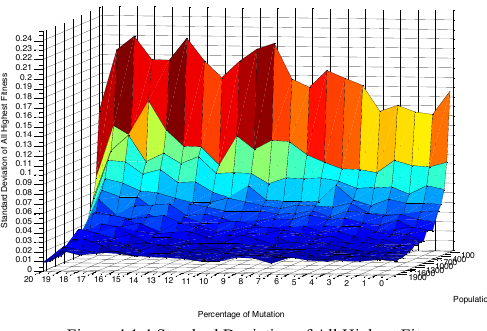
Figure 4.1.4 Standard Deviation of All Highest Fitness Figure 4.1 Total Percentage of Mutation and Crossover is 20% (Crossover over